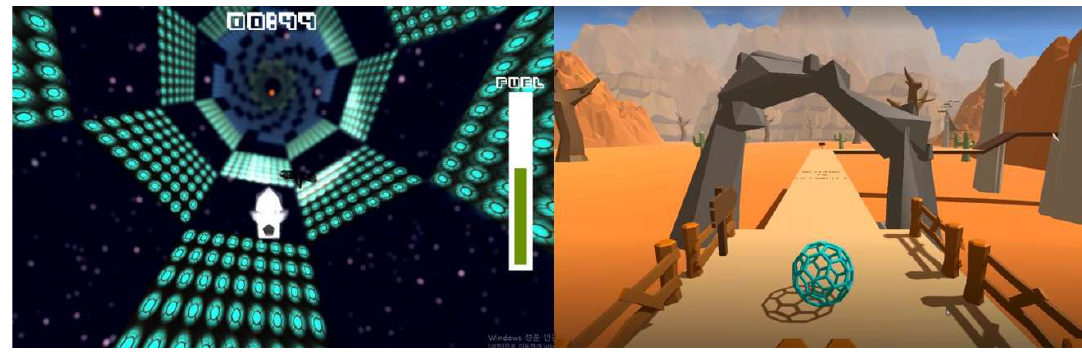
Figure 4. Development learning step—Beta Project.